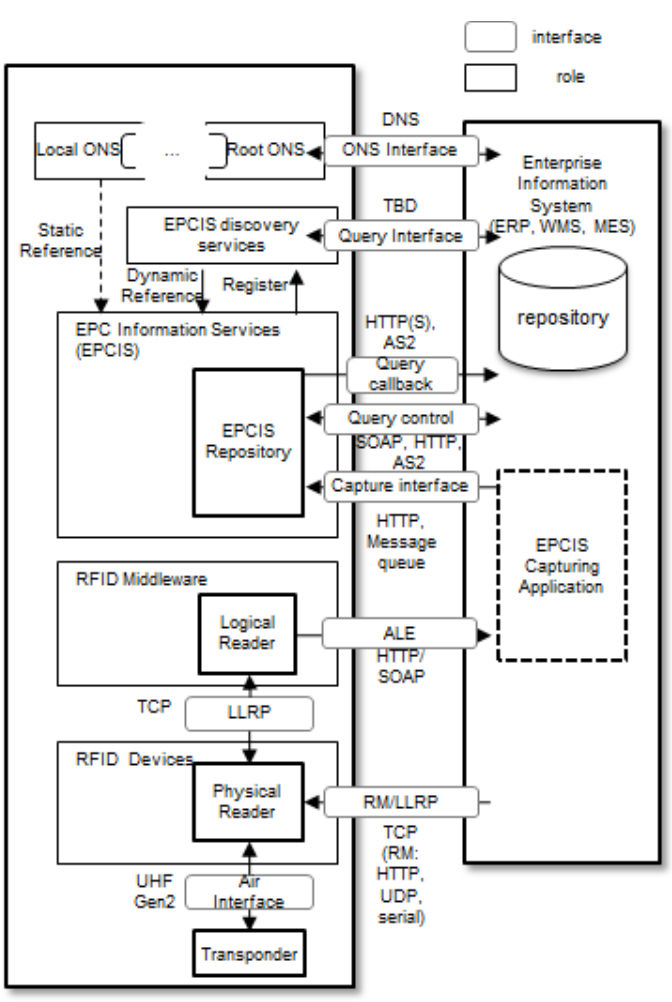
Figure 1. EPCglobal architecture framework (edited from [6]).